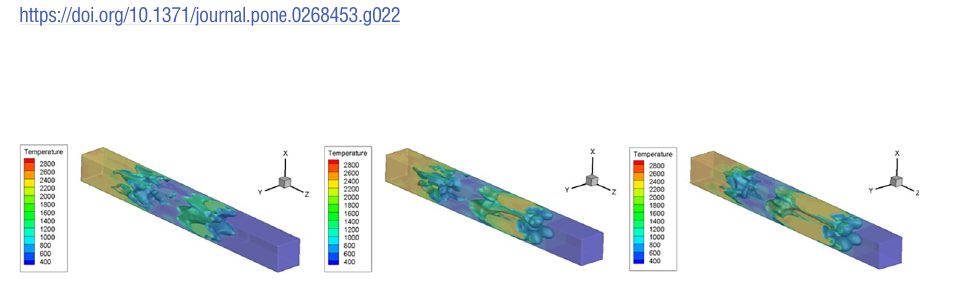
Fig 23. Temperature isosurface at different gas concentrations at 80 ms(5%; 9.5%; 16%).